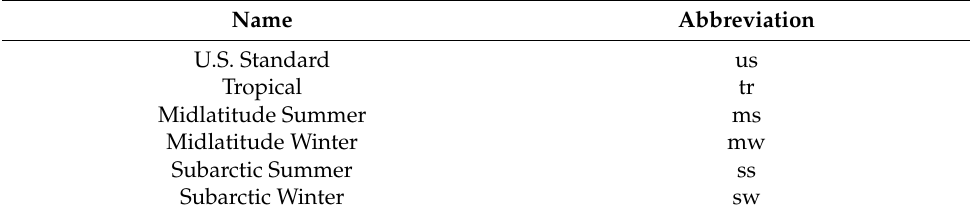
Table 3. Abbreviations for 15 different scenes, simulated in